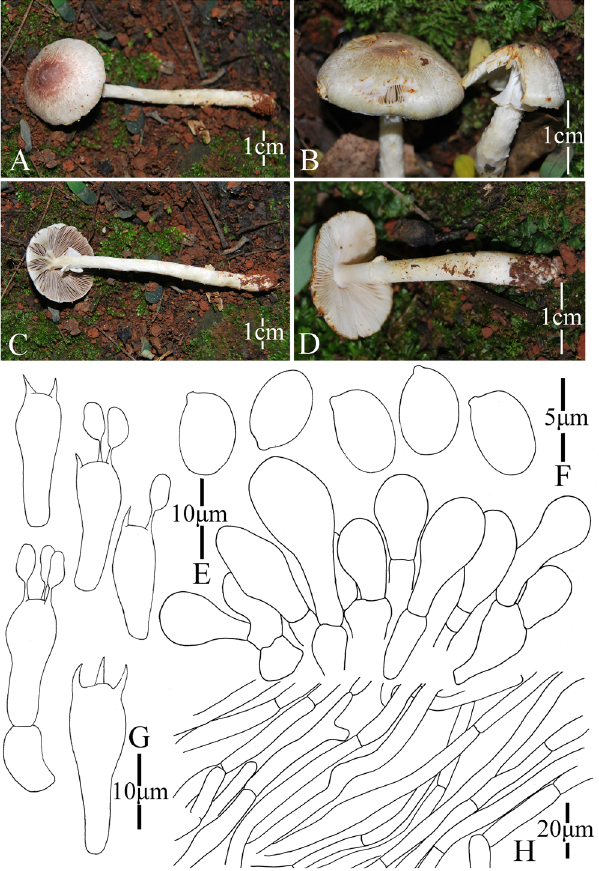
Figure 14. Morphology of Agaricus microviolaceus ( ZRL2012718 , holotype), ( A – D ): Basidiome in field ( A , C : ZRL2012718 ; ( B ): ZRL2012714 ; ( D ): ZRL2012717 ), ( E ): Cheilocystidia, ( F ): Basidiospores, ( G ): Basidia, and ( H ): Pileipellis